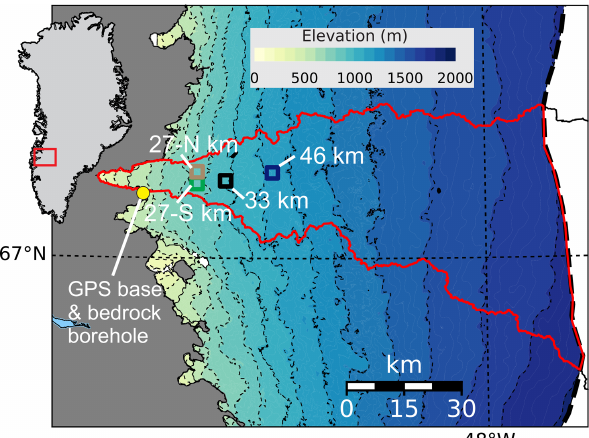
Figure 1. Map showing Isunnguata Sermia basin (red outline) in western Greenland. The inland basin boundary is clipped at the long-term position of the equilibrium line (see methods). Measure- ment sites are labeled as distance from the terminus. Datasets in- clude basal water pressure (at 27 ◦ S, 27 ◦ N; 33 and 46km), mete- orological data and surface melt (at 33km), and GPS speed (at 33 and